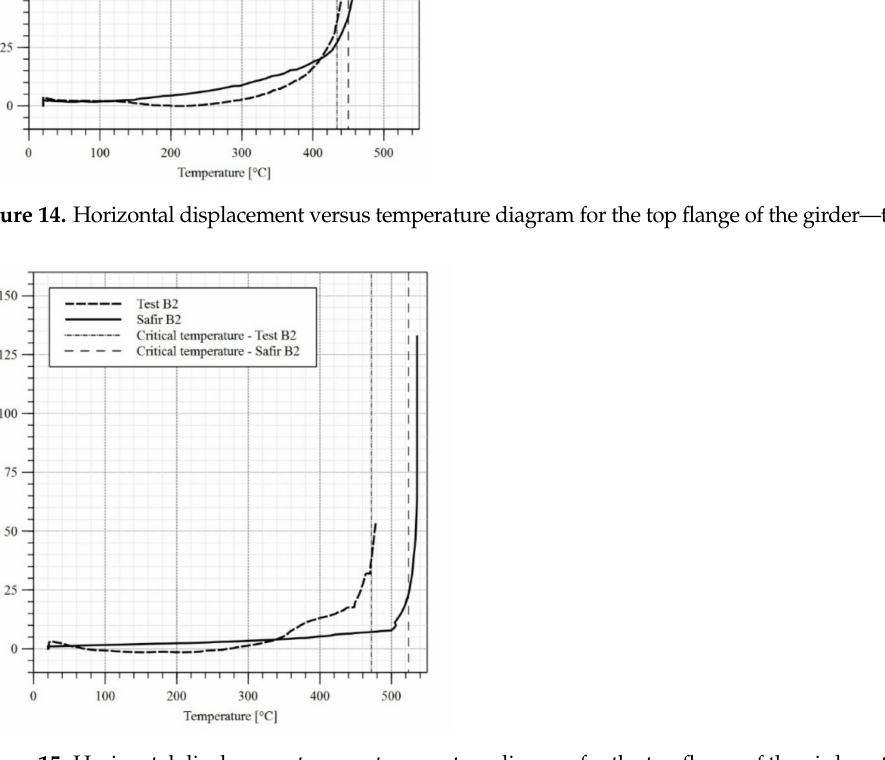
Figure 15. Horizontal displacement versus temperature diagram for the top flange of the girder—test B2.